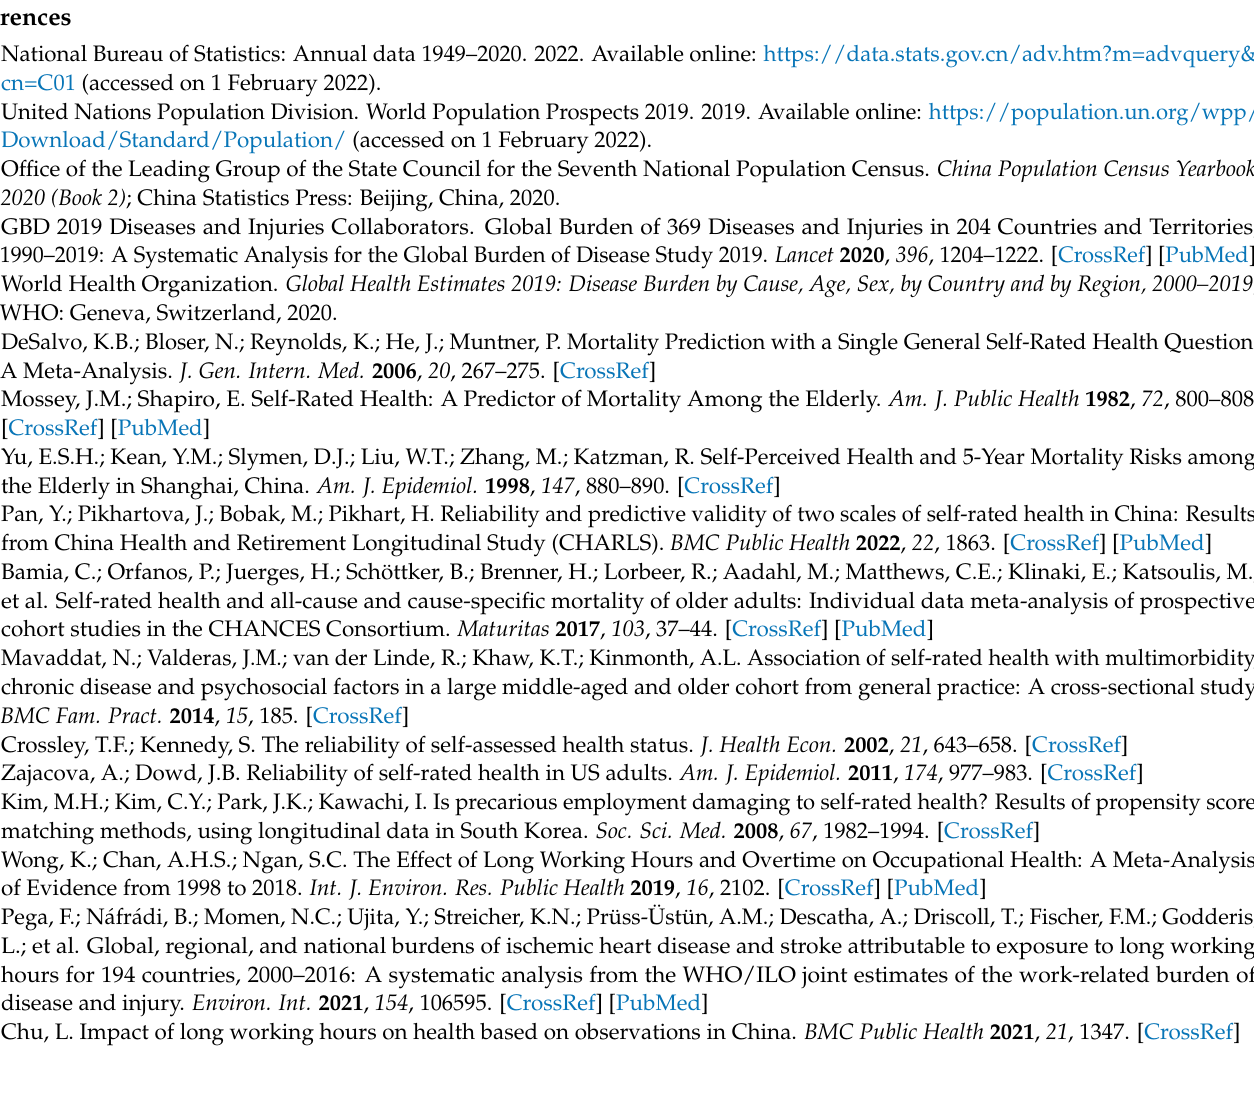
Figure S1. Four major economic regions in